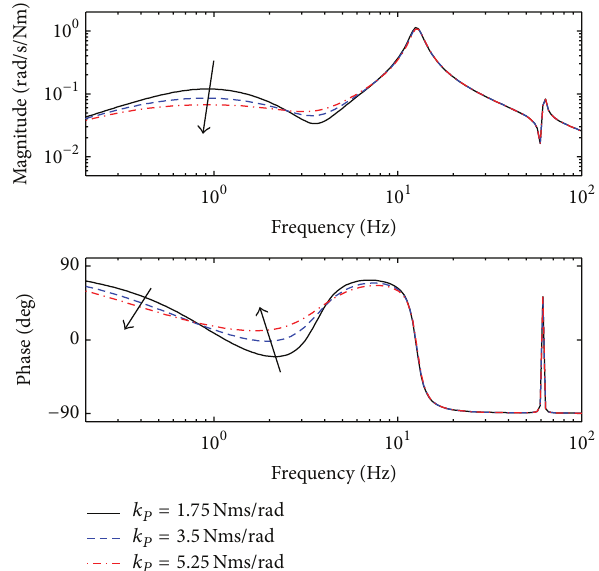
Figure 6: Sensitivity analysis: effect of the proportional gain of the PI speed controller on the FRF